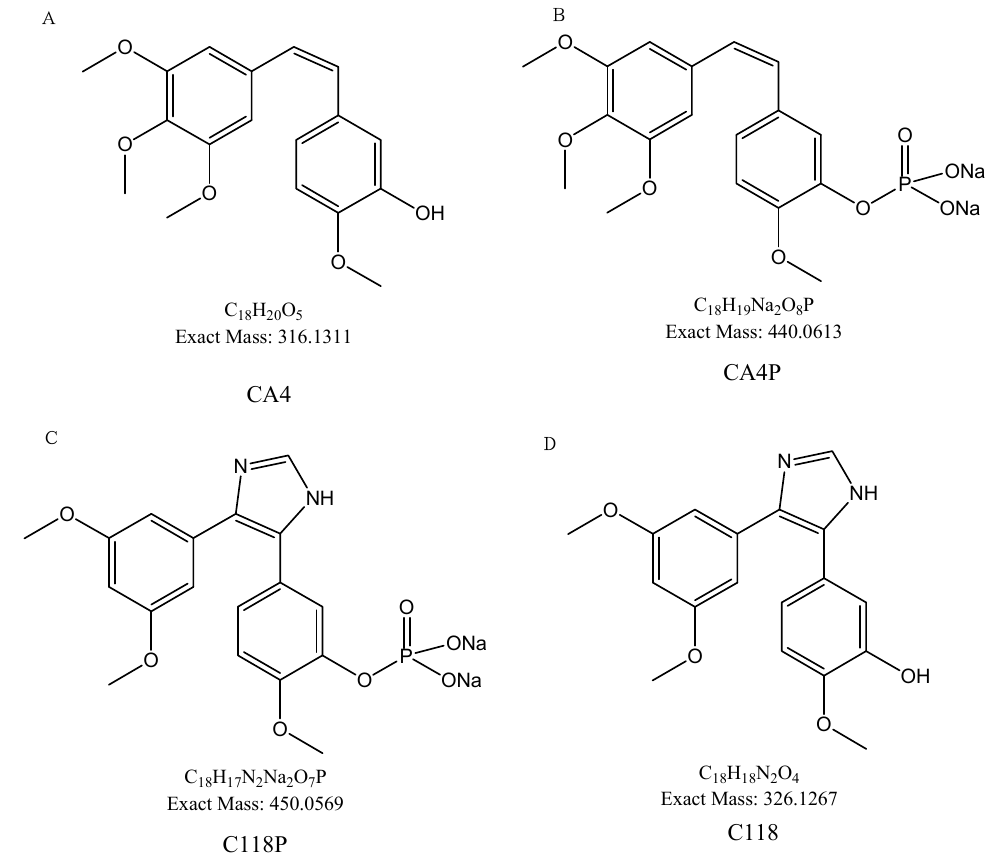
Figure 1. Chemical structure of CA4 ( A ), CA4P ( B ), C118P ( C ) and C118 ( D ).